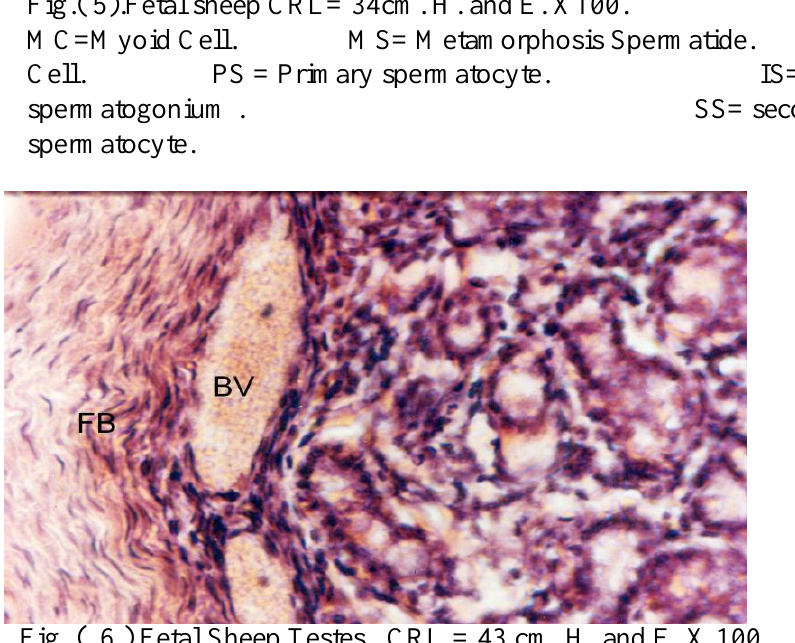
Fig. ( 6 ) Fetal Sheep Testes.. CRL = 43 cm. H. and E. X 100. Tunica Albugainea FB= Fibroblast. Tunica Vasculosa =